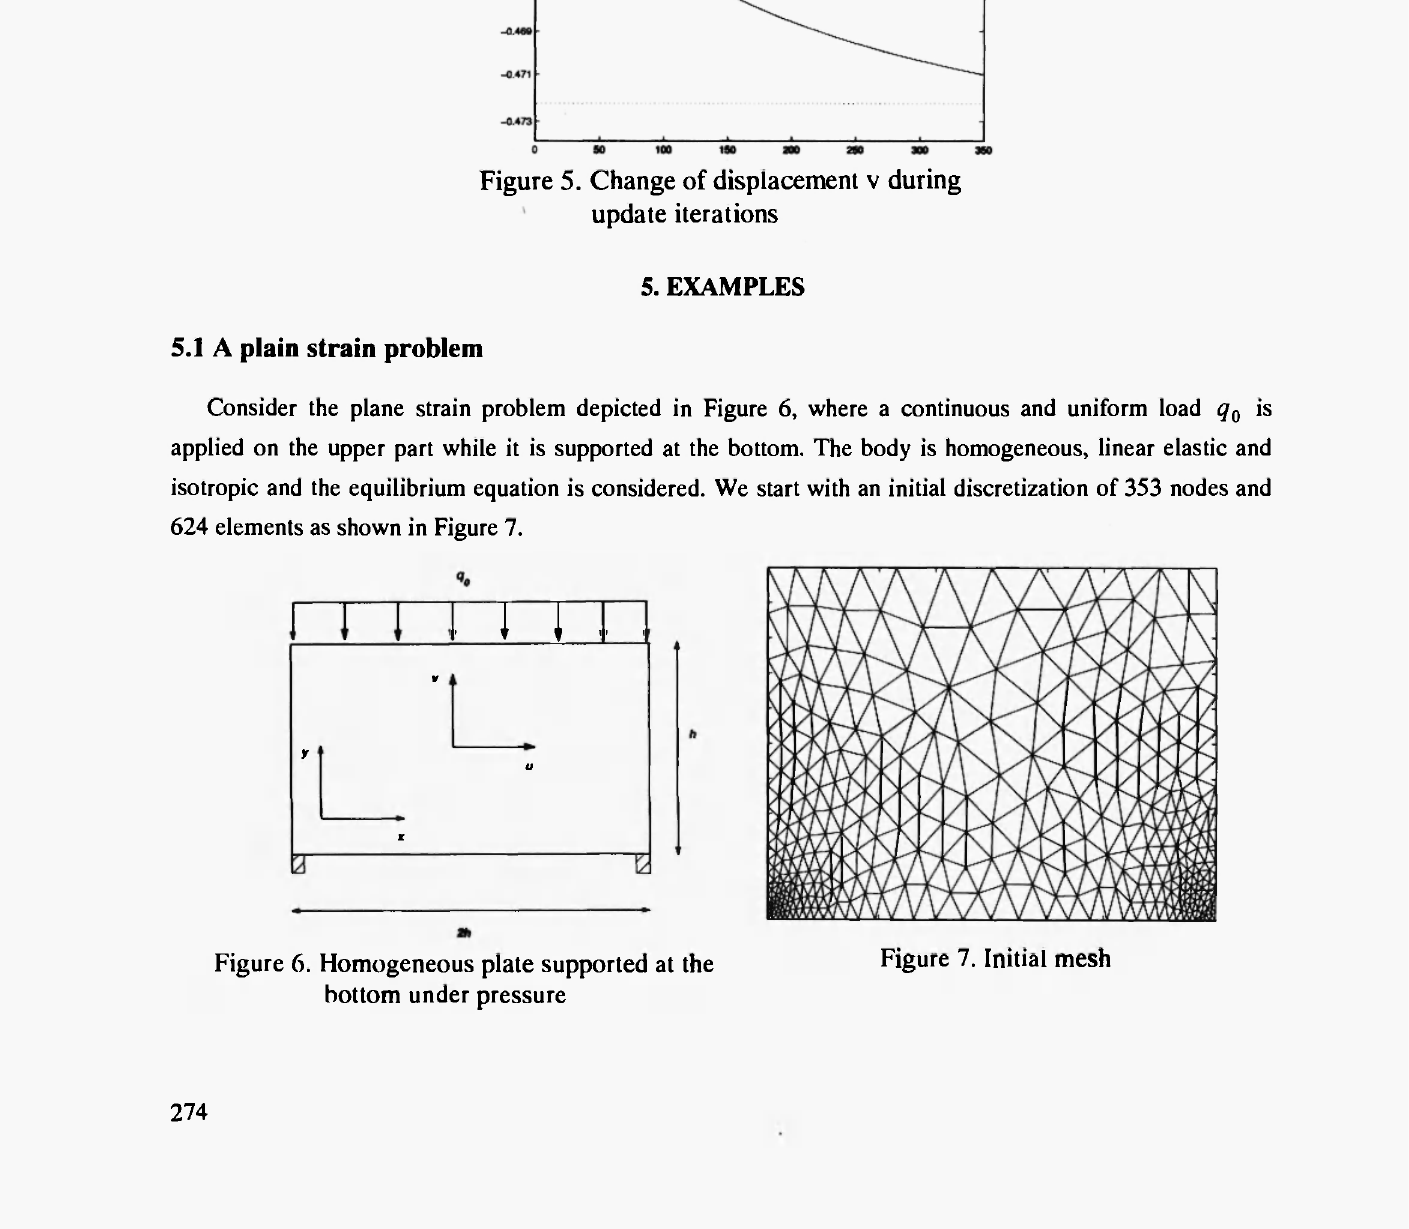
Figure 7. Initial